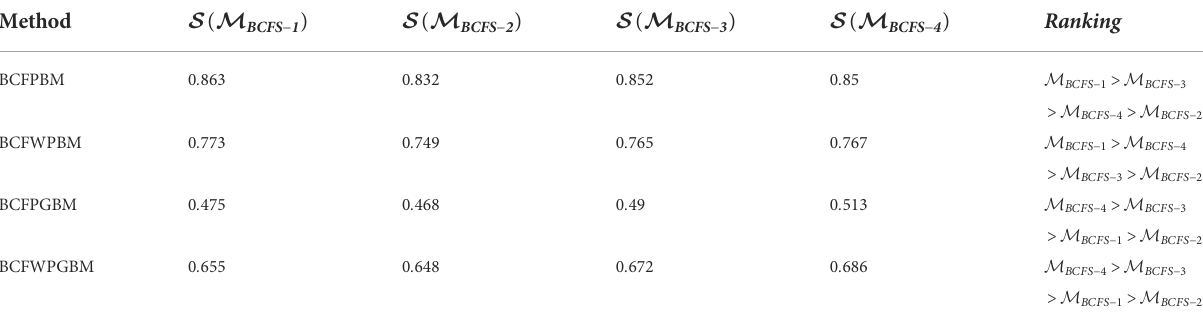
TABLE 3 SVs of the aggregated values of Table 2 and their